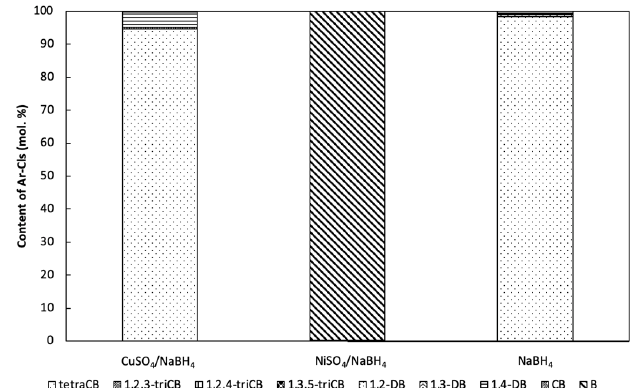
Figure 8. The composition of reaction mixture at the end of HDC of tetrachlorobenzenes using in situ generated Cu (CuSO 4 /NaBH 4 ), Ni (using NiSO 4 /NaBH 4 ) and comparison of action of the sole NaBH 4 (for more details see Supplementary Materials, Table S2). The experimental details are described in Section 4.2.3.